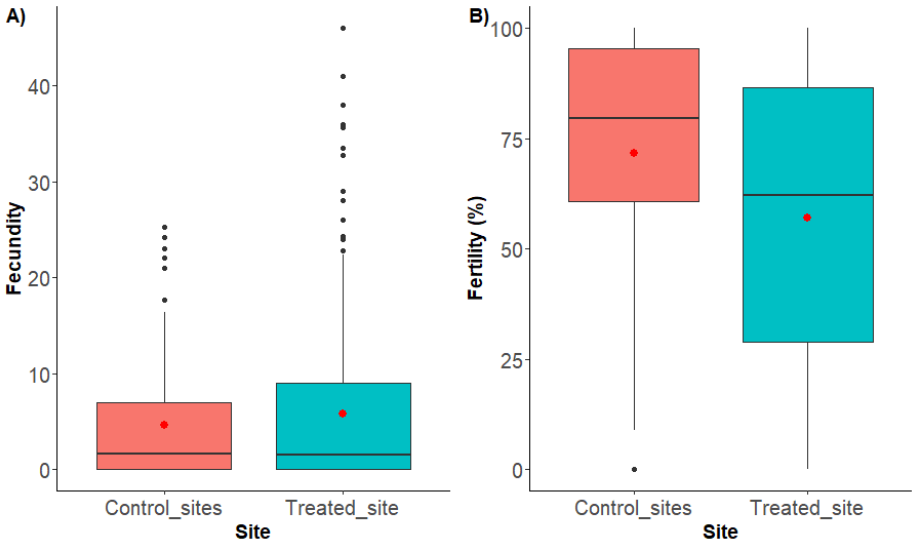
Figure 4. ( A ) Fecundity and ( B ) fertility of wild female D. suzukii collected from SIT-treated and control sites (combined) from week 30 to week 41. Fecundity is calculated as the number of eggs laid per female per 24 h. Fertility is calculated as the percentage of eggs that developed to pupae. Box plots represent the interquartile range of the median (horizontal line). Error bars represent variation of the data outside the interquartile range. Red dots represent the mean and black dots represent outliers. n = 1804 total females: 420 at untreated control sites; 1384 at SIT-treated site. Table 2. Summary of test statistics for the likelihood ratio tests analysing the interaction between D. suzukii infestation, SIT treatment and time of the year